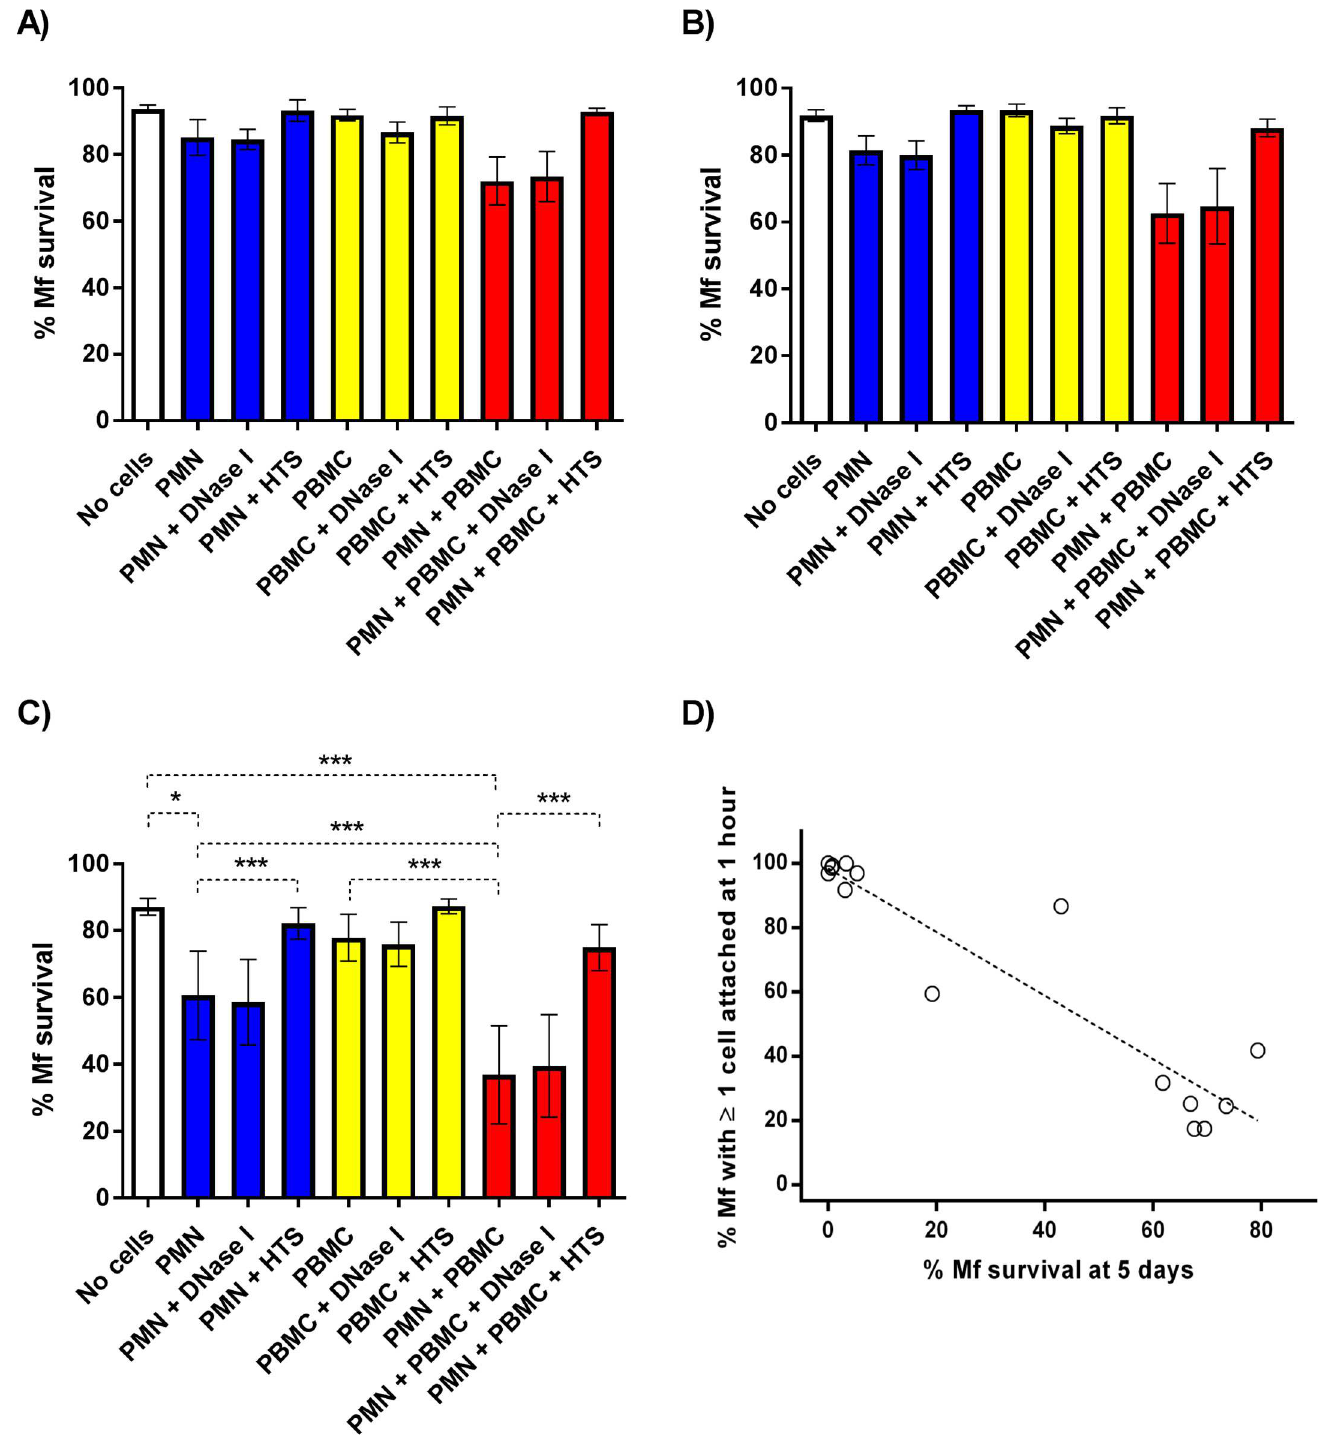
Fig 4. Mf survival in the presenceof PMNs and PBMCs. The percentage of Mf that survived to days 1 (A), 2 (B) and 5 (C) post-experimental set up (n = 5). White, blue, yellow, and red bars represent zero cell, 1500 PMN/Mf, 1500 PBMC/Mf and PMN plus PBMC treated wells respectively.All wells containedeither 25% autologous serum or 25% heat treated serum (HTS). DNase I denotesthe additionof 30 μ g/mlDNase I. Error bars represent standarderror of the mean; * P < 0.05, ** P < 0.01, *** P < 0.001. D. Scatter plot comparing leukocyte attachmentand Mf survival in the presenceof PMNs and PBMCs. The percentage of Mf that had at least one PMN/PBMC adheredto their surface or indirectly fastened by extracellular DNA at 1 hour post- experimental set up plotted againstthe percentage of Mf that survived to day 5 (n = 15). Each point represents an individualbiological replicate derived from distinct human blood donors. All wells contained25% autologous serum, ~100 Mf, ~150,000PMNs and ~150,000PBMCs. doi:10.1371/journal.pntd.0005279.g004 PLOS NeglectedTropical Diseases | DOI:10.1371/journal.pntd.0005279 January3,